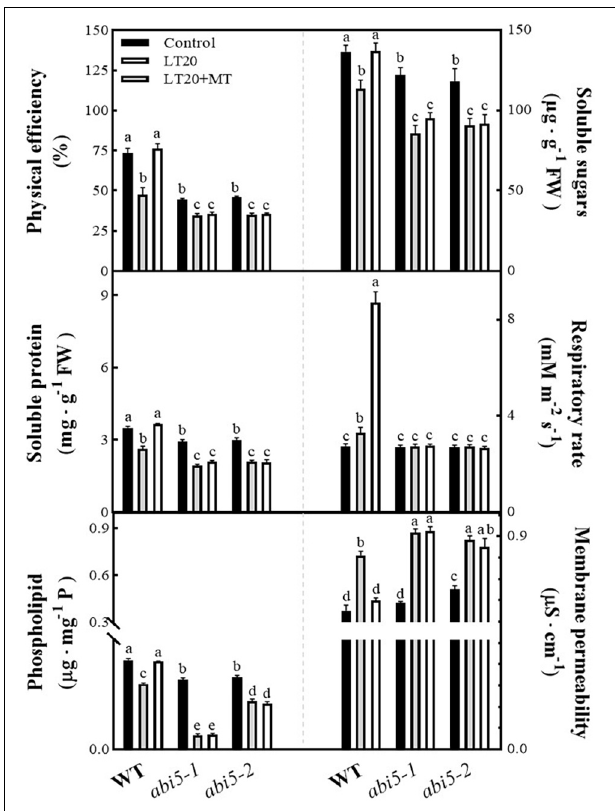
FIGURE 3 | Effects of exogenous MT treatment on seed germination-associated physiological attributes under LT stress. Physical efficiency, soluble sugar contents, soluble protein contents, phospholipid contents, respiratory rate, and membrane permeability under LT stress (constant 20 ◦ C for 7 days) without (LT20) or with (LT20 + MT) MT treatment. Different letters denote significant variations between the treatments, and the average values were measured by Tukey’s HSD test at p < 0.05. Data were represented as mean ± SE of six biological